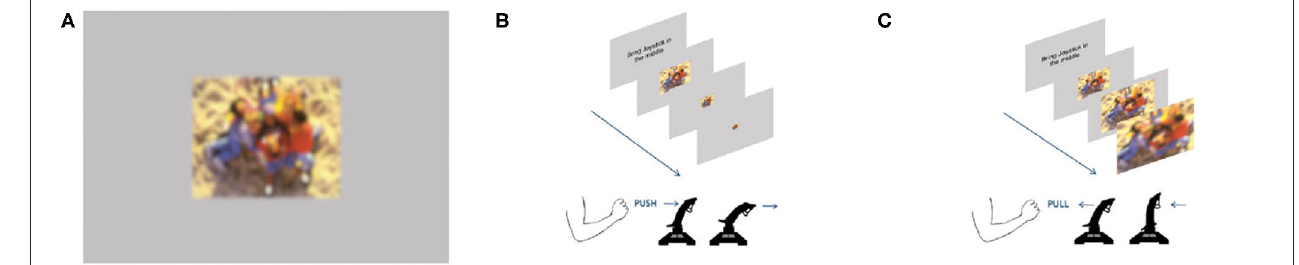
FIGURE 2 | Embodied primes used in the study. (A) Example of one priming stimulus: IAPS image with surrounding gray frame. This photograph depicts positive content with children laughing and playing on a sandy playground. Hint: Due to restrictions of showing IAPS images in public, it is masked with a diffusing filter. (B) Incongruent condition: joystick pushed forward—positive prime zooms out. (C) Congruent condition: joystick pulled backward—positive prime zooms